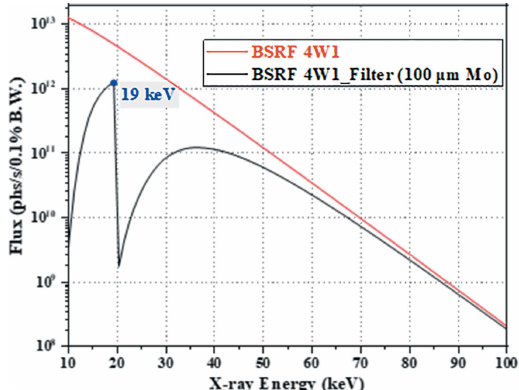
Figure 11 The spectrum of the pink beam was converted from the white beam of the BSRF 4W1A beamline using a 100 m m-thick Mo